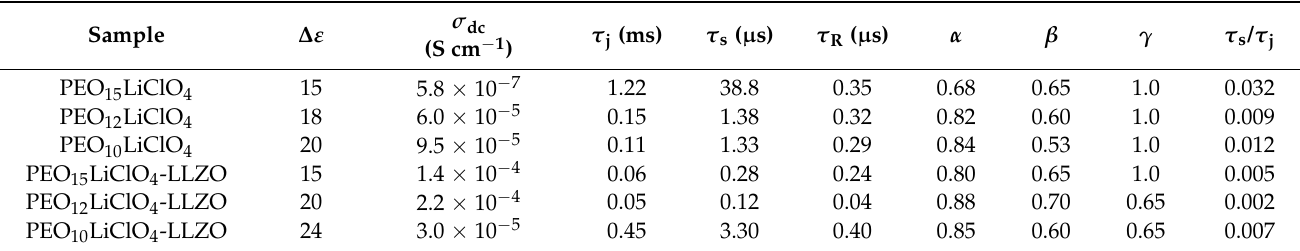
Figure 5. The frequency dependence of σ ′ and σ ′′ of ( a ) PEO n LiClO 4 and ( b ) PEO n LiClO 4 − LLZO films. The open circles and solid lines represent the experimental data and the fitted data. Table 1. The ionic ( τ j ) and segmental ( τ s ) relaxation times, and other parameters obtained from fitting the complex dielectric permittivity and conductivity of PEO n LiClO 4 and PEO n LiClO 4 ‐ LLZO at 30 °C. Sample